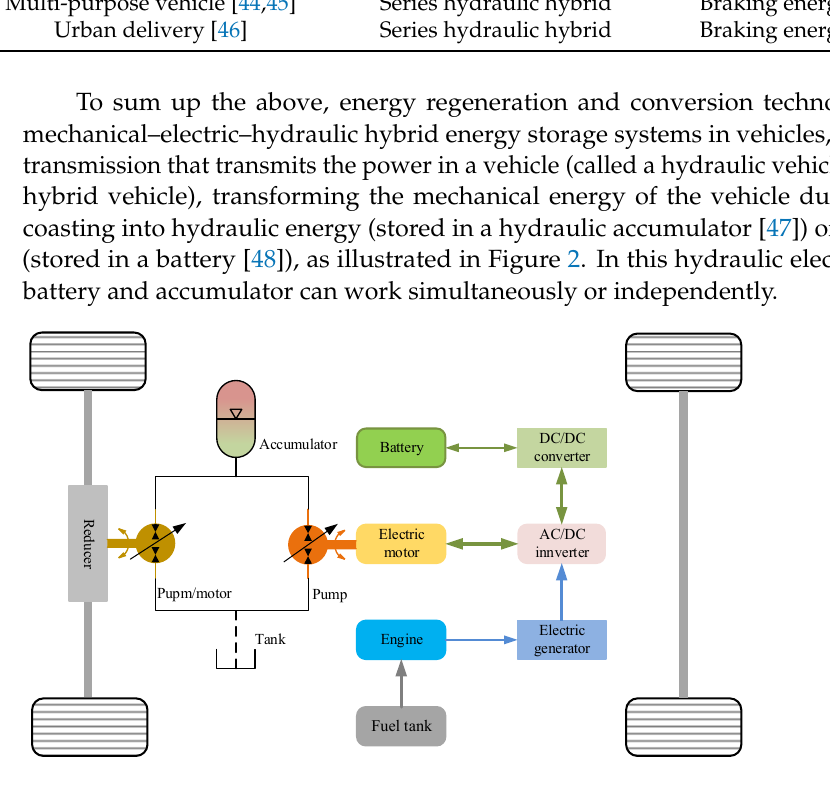
Figure 2. Working process of the energy recuperation and conversion technology of hydraulic ve ‐ Figure 2. hicles [47,48].